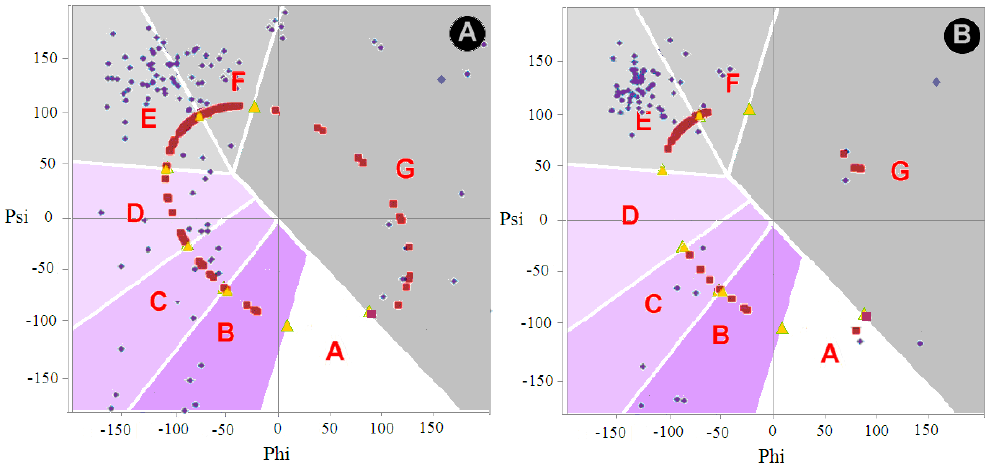
Figure 4. Phi, Psi angle distribution in the structure: ( A ) Immunoglobulin G chain light domain V (4BJL); ( B ) amyloid form (6HUD); only angles for 2–37 and 66–105 are shown in the maps. A–G—zones on Ramachandran map distinguished according to local maxima on the ellipse